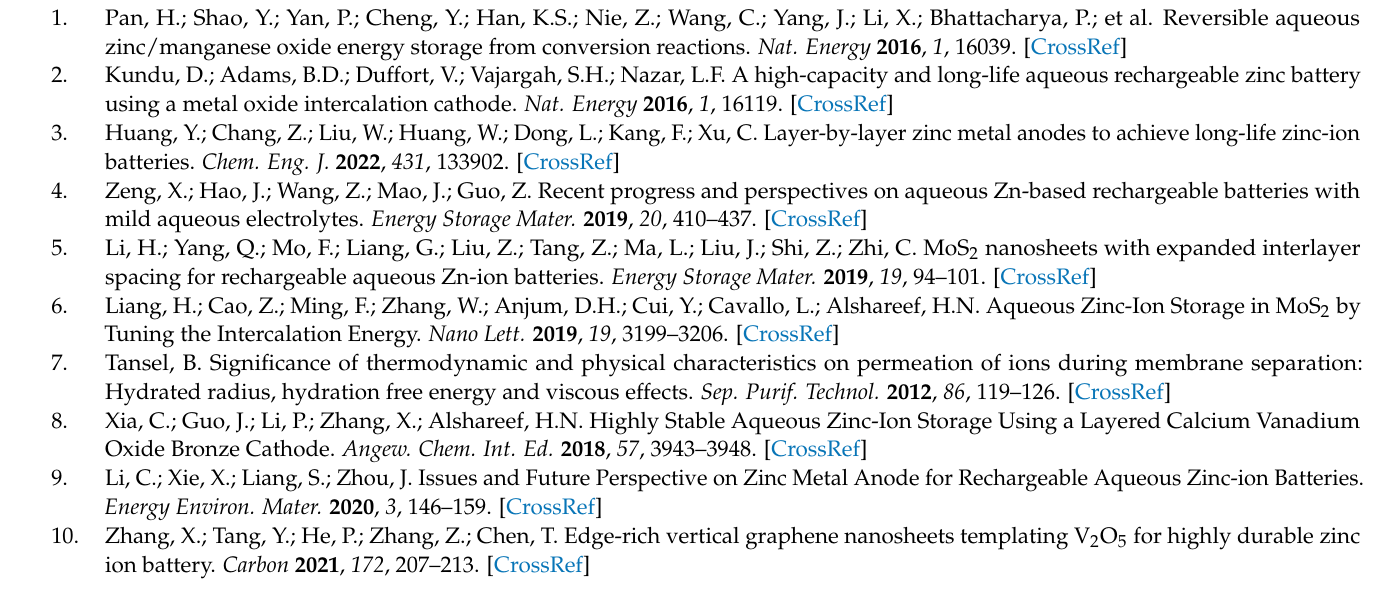
MoS2; Figure S2. TThe corresponding atomic intensity profile along the dotted red line for P- MoS2; Figure S3. TEM images of (a,b) Pristine MoS2; Figure S4. Line scan of the HRTEM image; Figure S5. EDS spectrum; Figure S6. Contact angles with water for (a) P-MoS2 and (b) Pristine MoS2; Figure S7. XPS spectra of full scan for P-MoS2; Figure S8. The initial five CV curves of (a) Pristine MoS2 and (b) CV curves at various scan rates of Pristine MoS2; Figure S9. Inital charge- discharge profile of P-MoS2 nanosheets at 0.1A g-1; Table S1. Phase content of Mo 3d in each sample; Table S2. Atomic percentages of P-MoS2 by XPS measurement; Table S3. Comparisons of performance of MoS2 synthesized under different conditions in neutral media; Table S4.